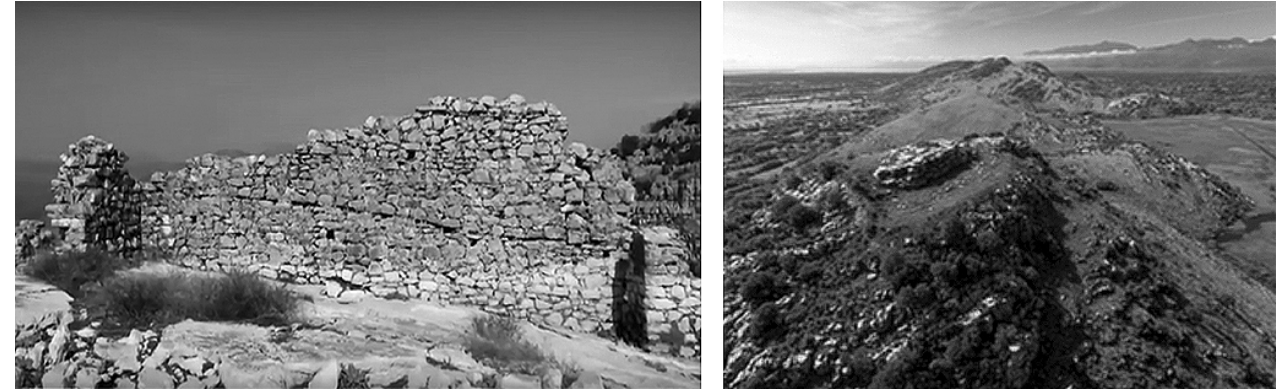
Figure 6. Oblun (Photo: D. Starcevic) .